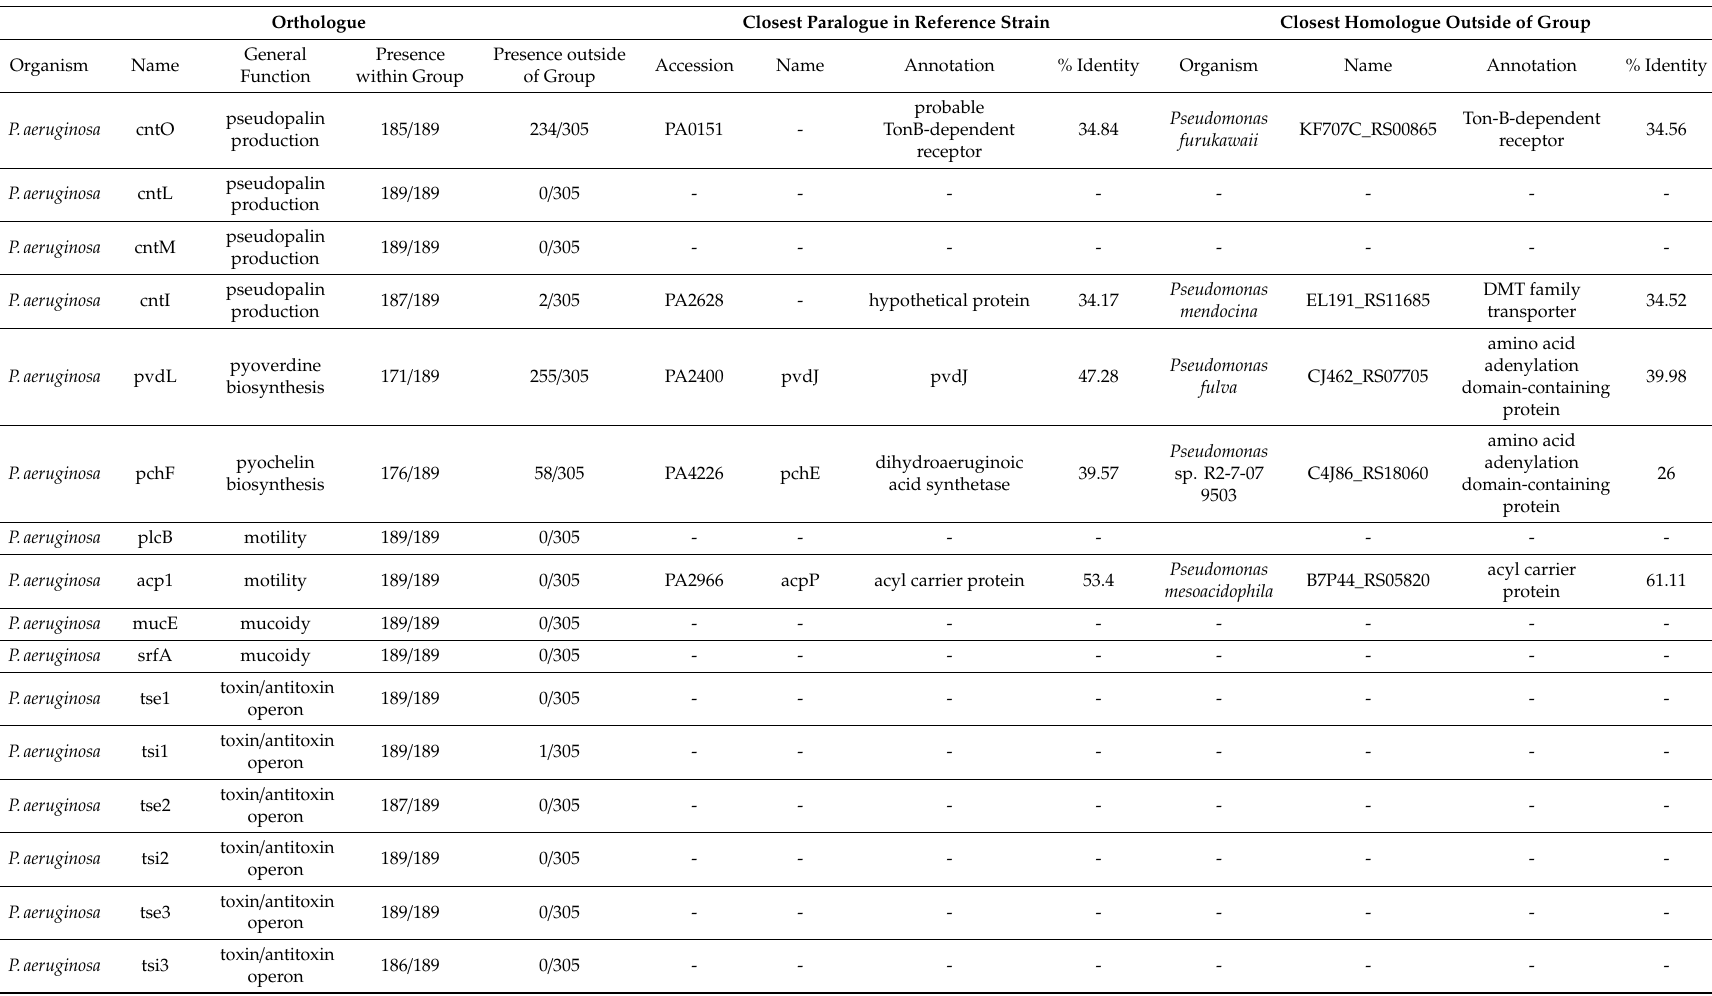
Table 2. Summary of important group-specific and related proteins in P. aeruginosa and P. chlororaphis